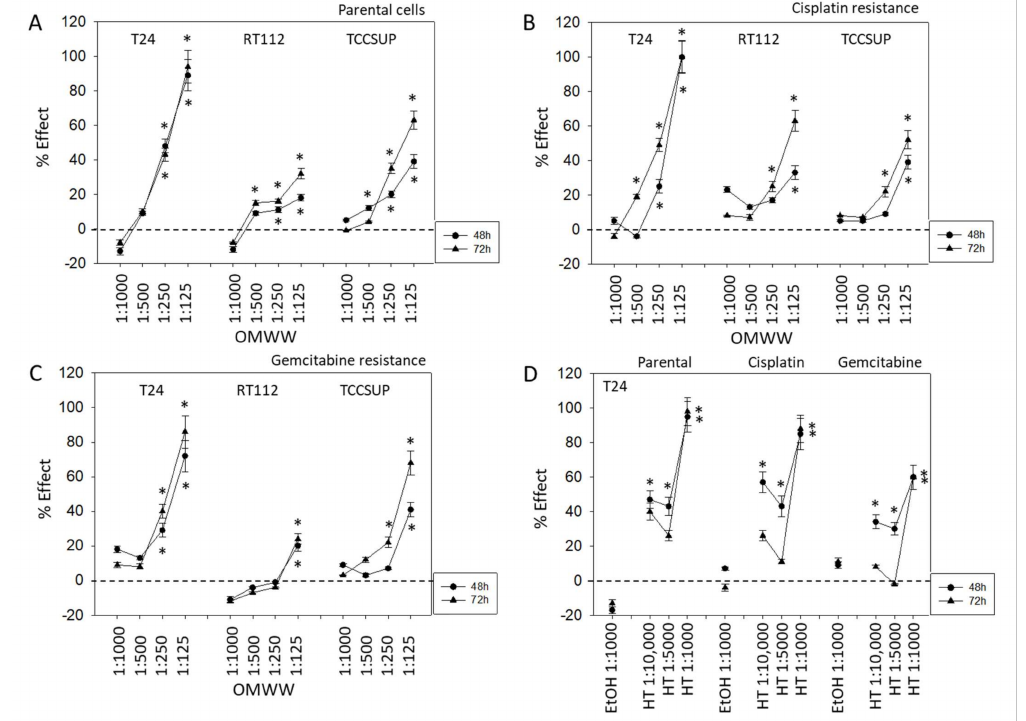
Figure 2. Influence of 48 and 72 h OMWW incubation on the growth of parental ( A ), cisplatin- ( B ) and gemcitabine-resistant ( C ) T24, RT112, and TCCSUP bladder cancer cell lines. Efficacy is expressed as a percentage compared to controls (without OMWW) set to zero. ( D ) Efficacy of different hydroxytyrosol (HT) concentrations or ethanol in diminishing the number of T24 tumor cells (parental, cisplatin-, and gemcitabine-resistant), compared to the control (EtOH 1:1000) set to zero. Error bars indicate standard deviation (SD), n = 5. * indicates significant difference to the corresponding